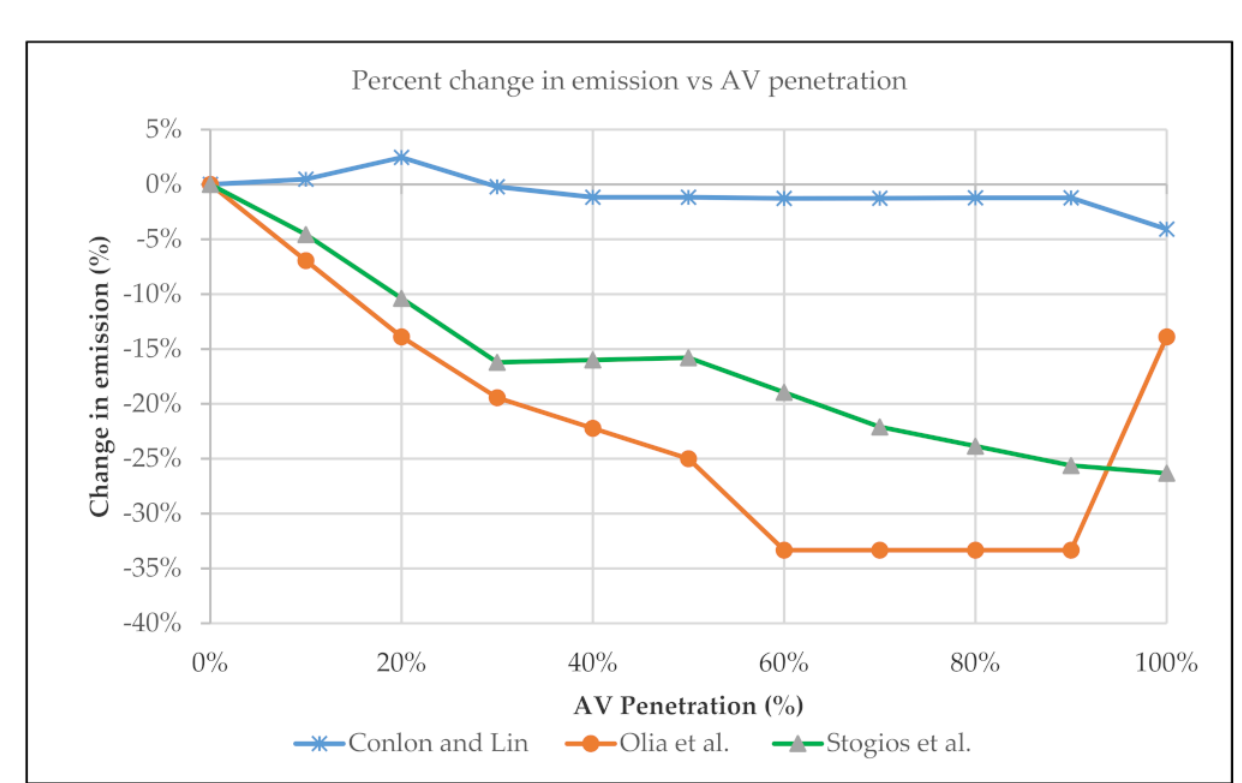
Figure 2. Emission changes by AV penetration